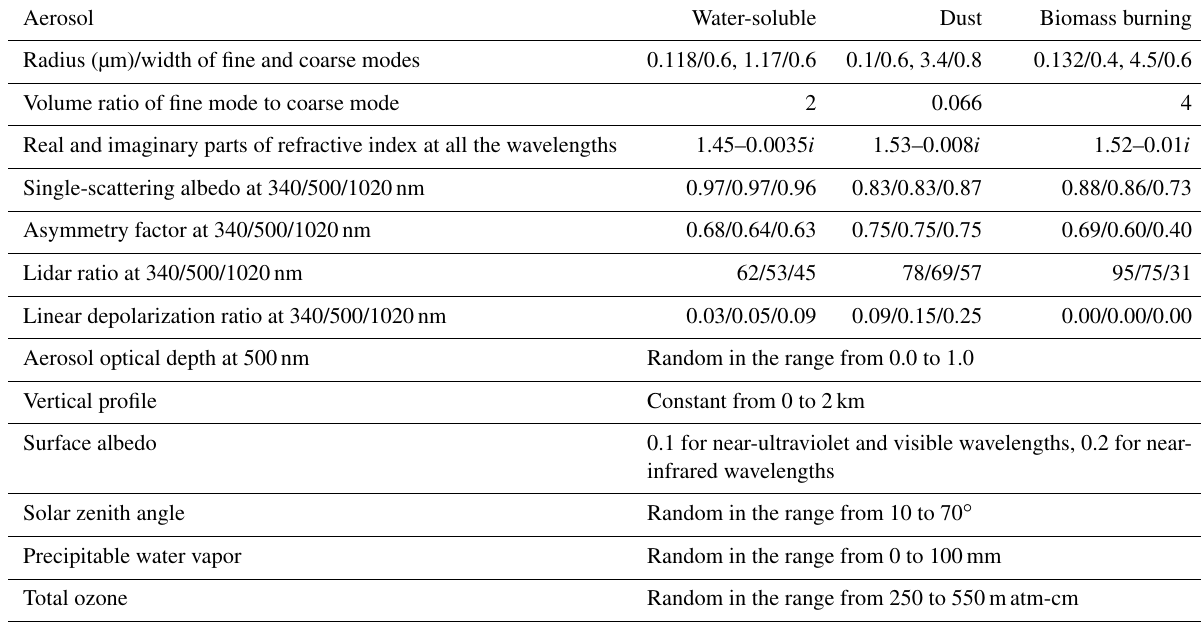
Table 1. Configuration of the simulation in the assessment of retrieval uncertainties. Aerosol